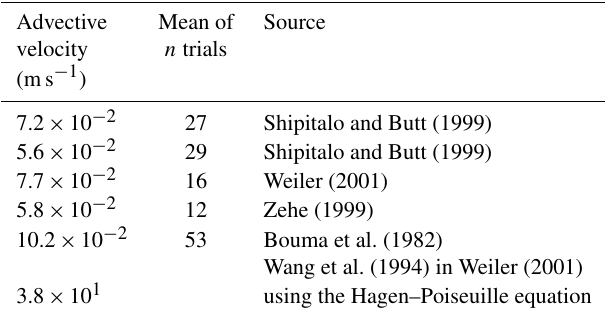
Table 1. Measured mean maximum advective velocity in burrows of the earthworm Lumbricus terrestris at a mean radius of 4.5mm and theoretical value calculated using the Hagen–Poiseuille